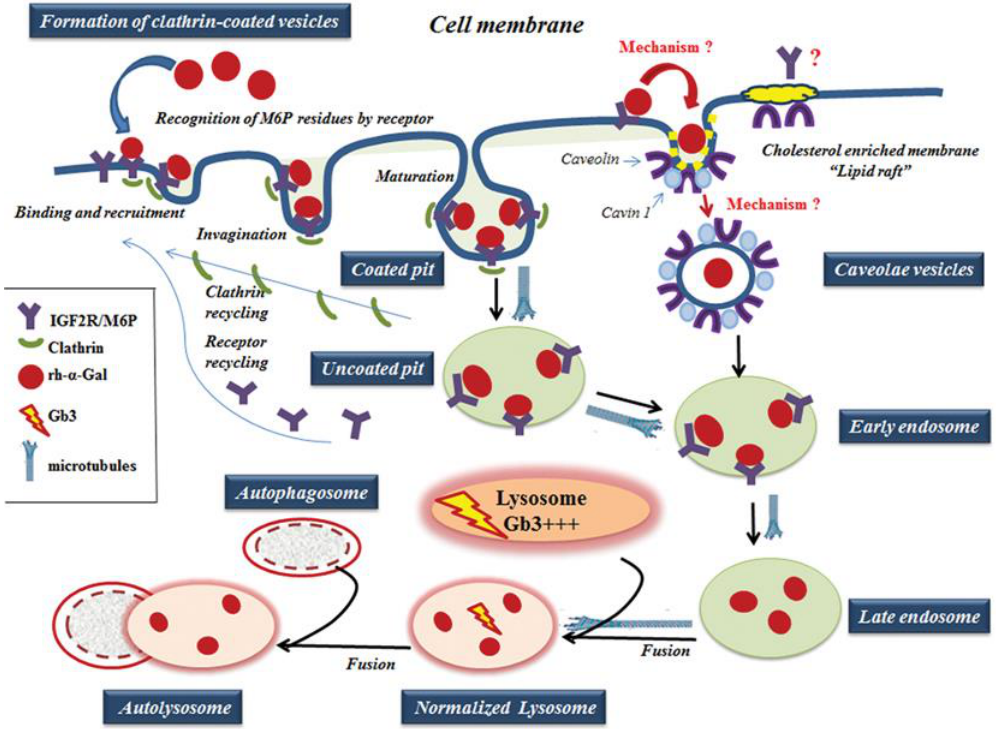
Figure 9. A working model of rh- α -Gal A uptake through clathrin- and caveolae-mediated endocytosis. The rh- α -Gal A contains terminal mannose residues for which conferring the high a ffi nity for IGF2R / M6P on cells. The model proposes that the IGF2R / M6P internalizes the majority of the rh- α -Gal A through clathrin-meditated endocytosis. A small portion of IGF2R / M6P—rh- α -Gal A complex can also be uptake by caveolae-endocytic mechanisms. The microtubule cytoskeleton is involved in rh- α -Gal A endocytosis and transport enzyme to lysosomes. Early endosomes are containing recombinant enzyme mature into late endosomes, while IGF2R / M6P is recycling back to the cellular membrane. Late endosomal fuses with lysosome and delivers the therapeutic enzyme to the lysosome, which subsequently normalized Gb3 level. Normalized lysosomes fused with autophagosomes and form autolysosomes.